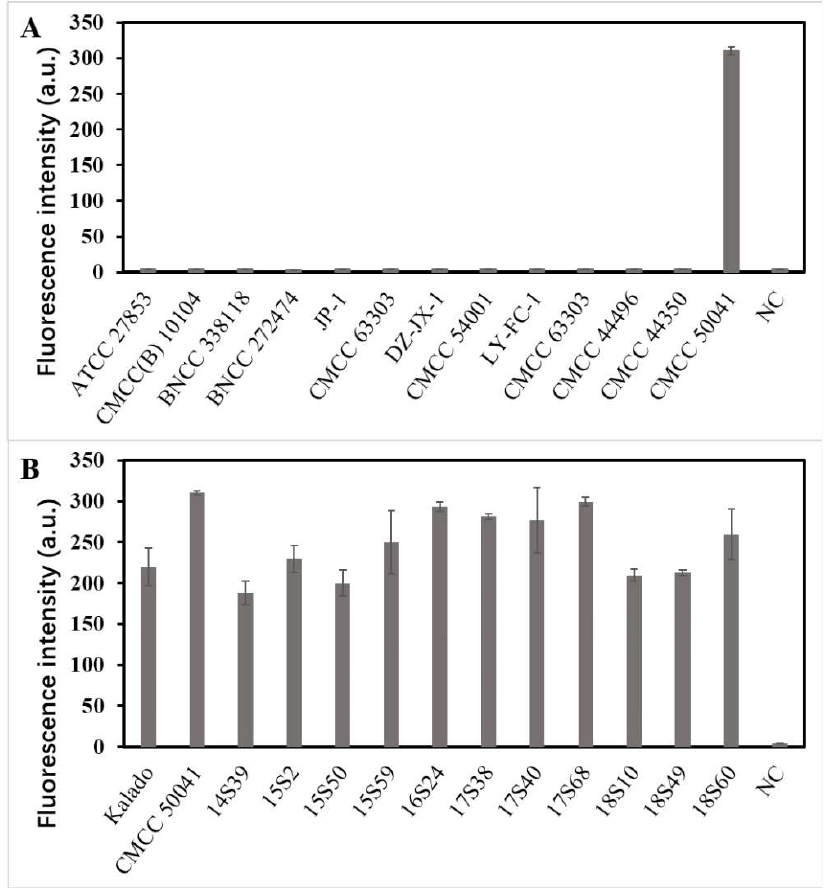
Figure 4. Estimating the specificity and sensitivity of LAMP–CRISPR detection system for Salmonella detection. ( A ) Fluorescence intensity using non- Salmonella standard strains for specific evaluation. ( B ) Fluorescence intensity using Salmonella standard strains for sensitive